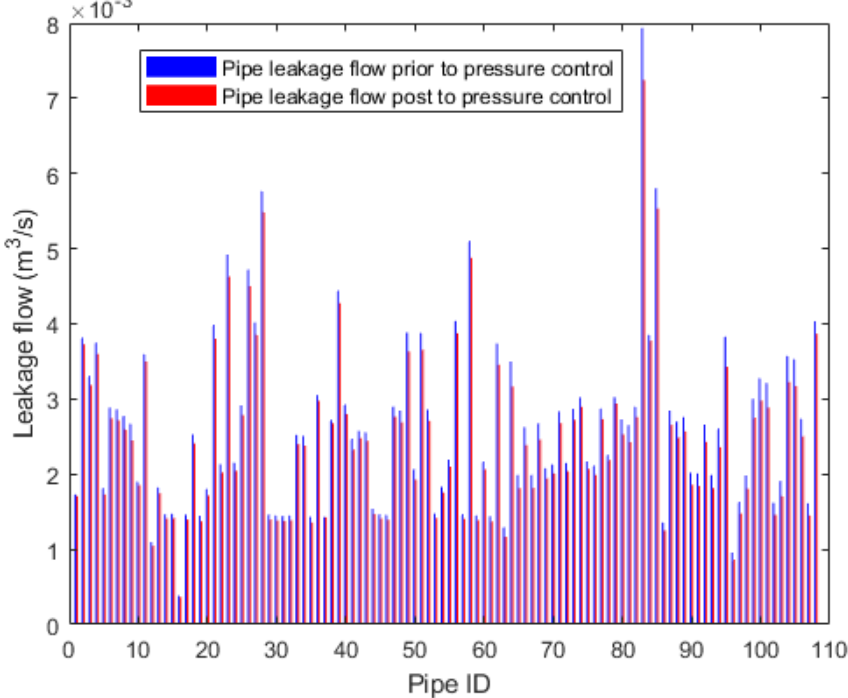
Figure 5. Pipe leakages prior to and post pressure control.